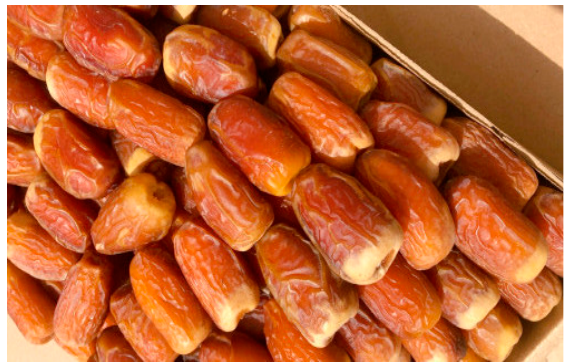
Figure 21. Sample of Al-sagai dates.